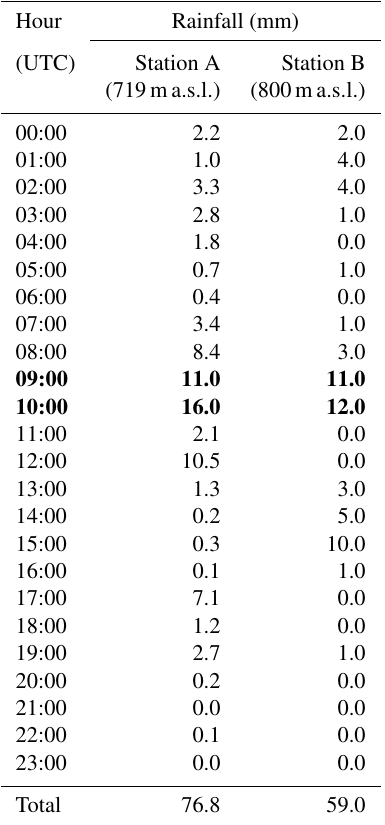
Table 1. Rainfall registered on 30 October 2005 at the two rain gauge stations near the Zêzere valley. Stations A and B are located at a linear distance of ca. 8 and 8.5km from the path of the de- bris flows, respectively. Bold values indicate the 2h period with the highest values of